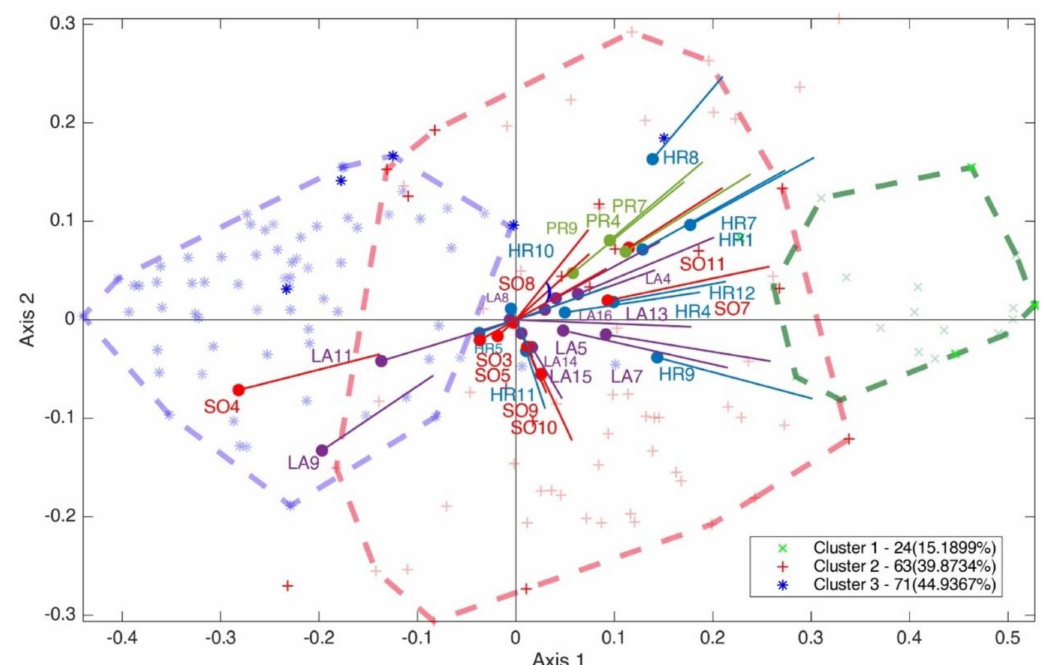
Figure 2. External Logistic Biplot with cluster: disclosure of social indicators.